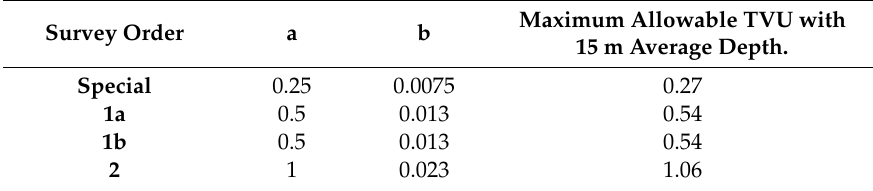
Table 2. The total vertical uncertainty (TVU) allowed by the IHO for all survey orders estimated at 15 m average